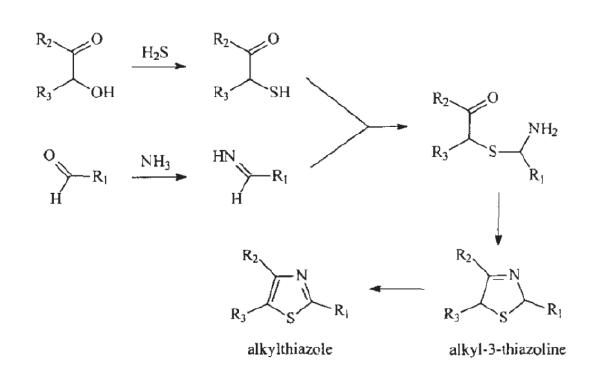
Figure 4. Strecker degradation of amino acids and the formation of hydrogen sulfide, ammonia and acetaldehyde from cysteine (Mottram, 1998).